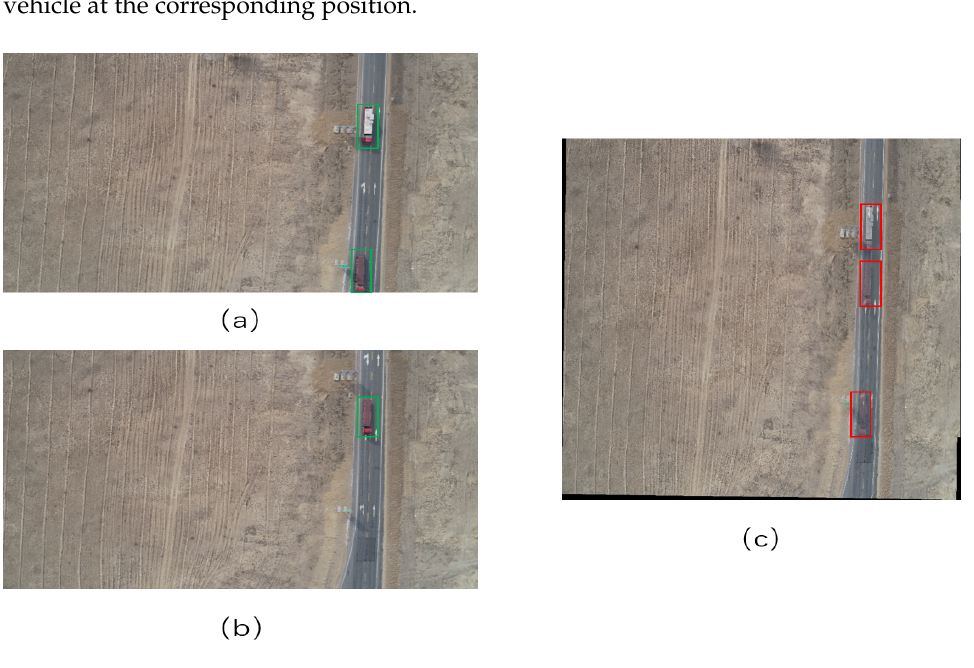
Figure 3. The two stitched images using Equation (4). ( a ) Image to be stitched with trucks, ( b ) another image to be stitched with a truck, ( c ) the result of ( a , b ) to be stitched by Equation